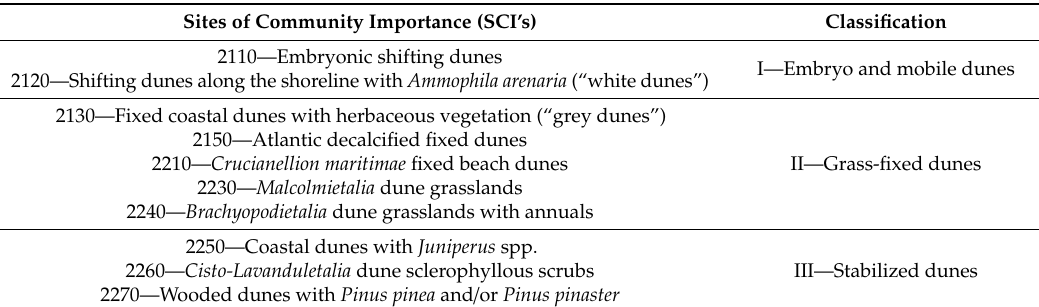
Table 2. Sites of Community Importance (SCI’s) described in the study area and their correspondence with the dune typologies mapped in this work